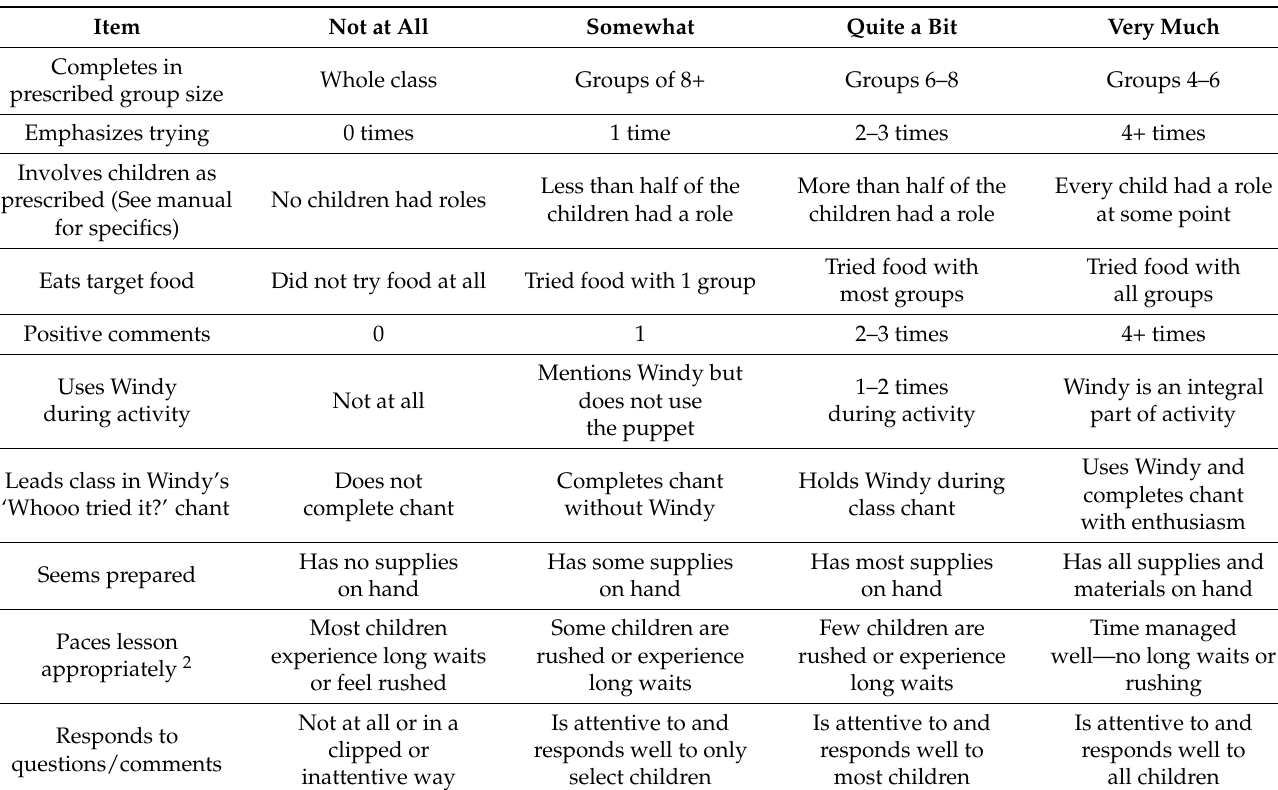
Table 1. WISE 18-item Fidelity Measure 1